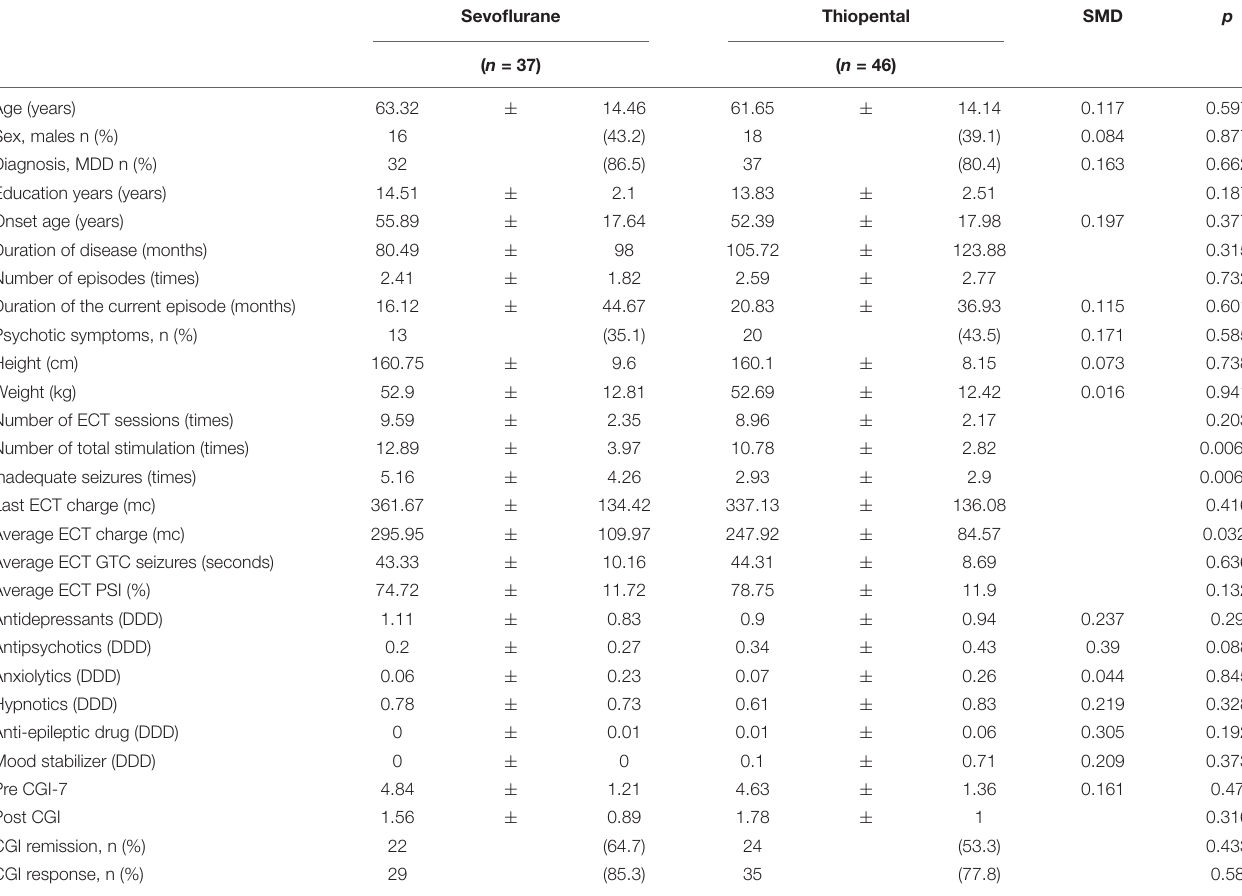
TABLE 1 | Participant characteristics before propensity score matching.